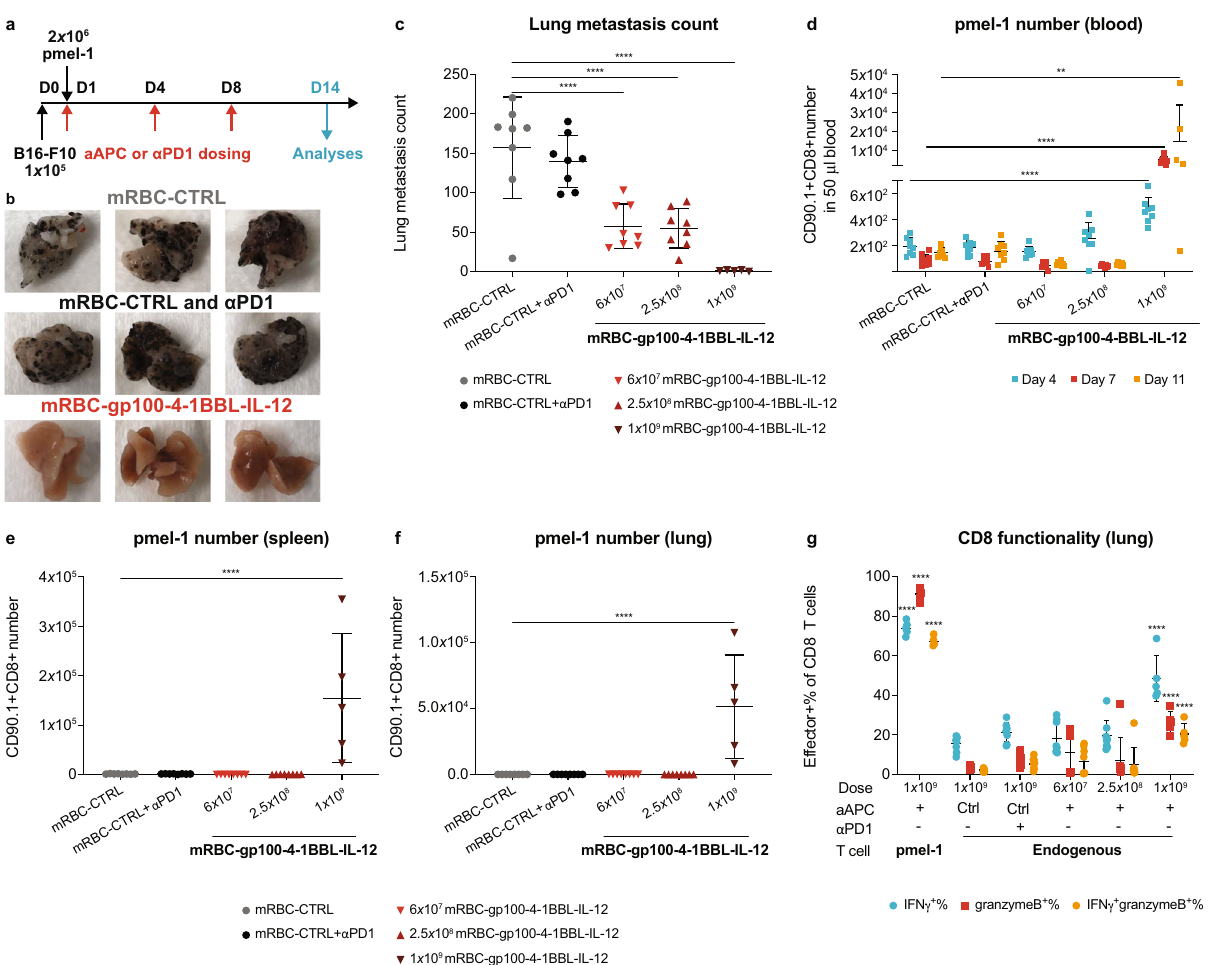
Fig. 5 mRBC-aAPCs targeted against a tumor-associated antigen (gp100) promote antigen-speci fi c pmel-1 T-cell expansion and effector function and dramatically reduce lung metastasis of B16-F10 tumors. a C57BL/6 mice were injected intravenously with 1 × 10 5 B16-F10 tumor cells on day 0 followed by transfer of 2 × 10 6 naïve pmel-1 T cells on day 1. Mice ( n = 8) were then dosed with 1 × 10 9 mRBC-CTRL, 1 × 10 9 mRBC-CTRL with anti-PD-1 ( α PD-1), or 1 × 10 9 , 2.5 × 10 8 , or 6 × 10 7 mRBC-gp100-4-1BBL-IL-12 on days 1, 4, and 8. Analyses were performed on day 14 unless otherwise speci fi ed. For 1 × 10 9 mRBC-gp100-4-1BBL-IL-12, n = 5 for day 14 analyses. b Representative lung photos of 1 × 10 9 mRBC-CTRL, 1 × 10 9 mRBC-CTRL + α PD-1, or 1 × 10 9 mRBC- gp100-4-1BBL-IL-12-dosed mice. c Lung metastasis counts on day 14. One-way ANOVA P < 0.0001 compared to mRBC-CTRL at all dose levels. d – g